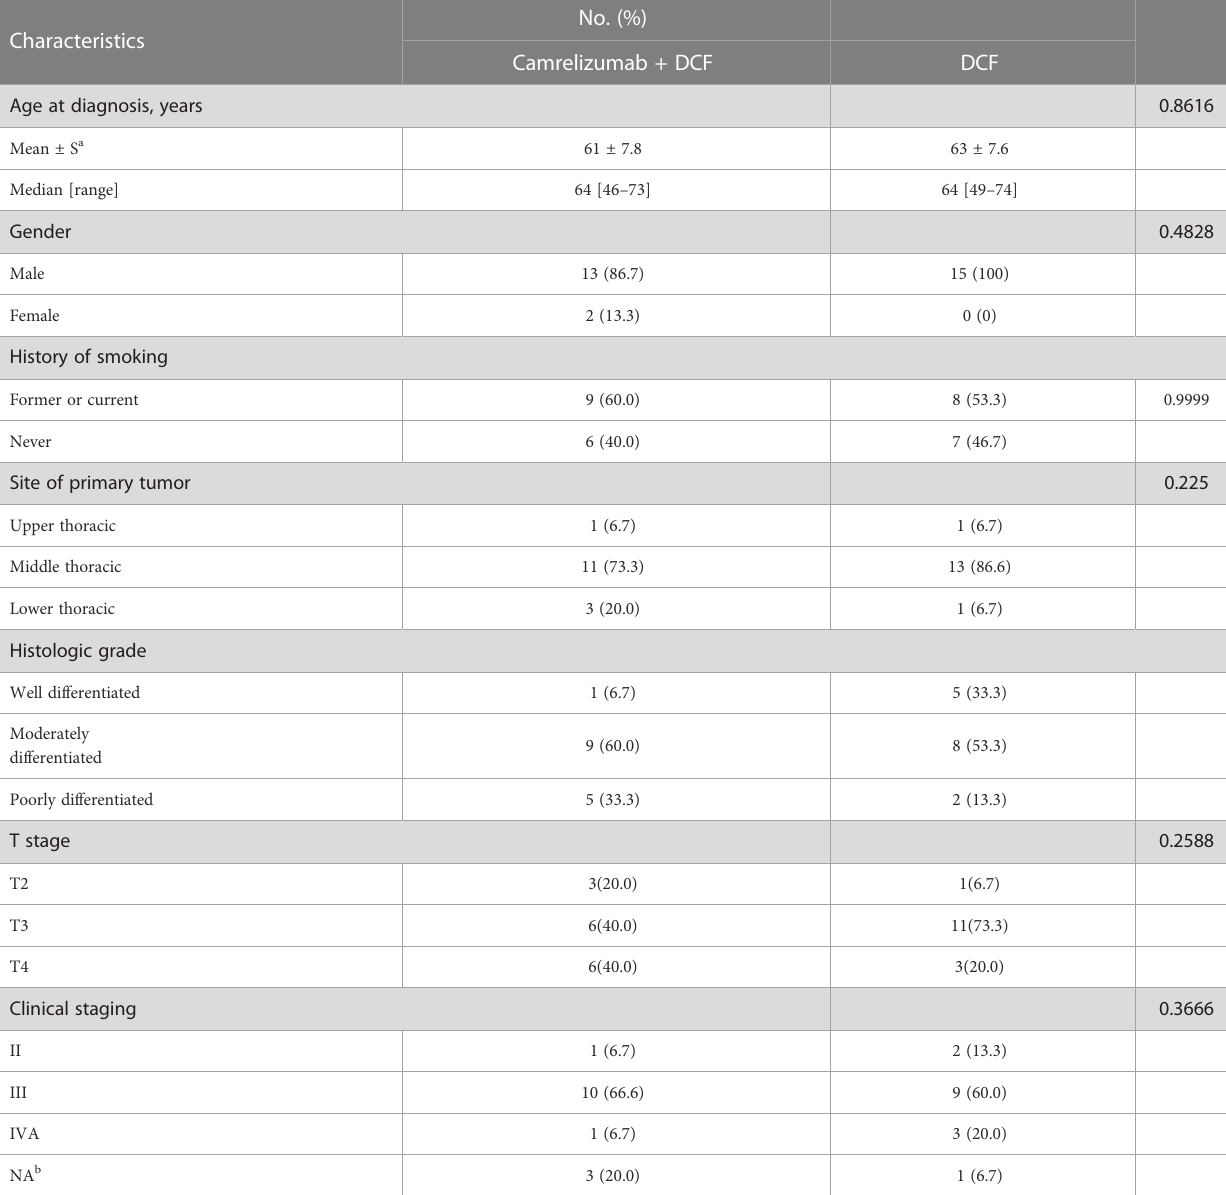
TABLE 1 Clinical characteristic of squamous cell carcinoma before